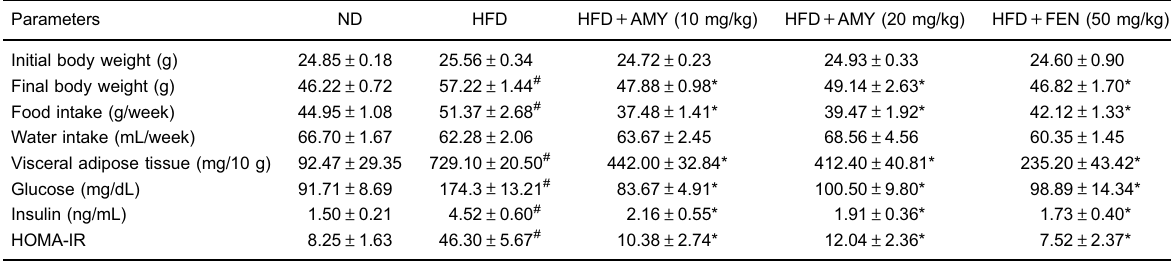
Table 2. Effect of a , b -amyrin (AMY) and feno fi brate (FEN) treatments on body weight changes, food and water intake, serum glucose and insulin levels, and insulin resistance in mice fed the high-fat diet (HFD) or normal diet (ND) for 15 weeks.